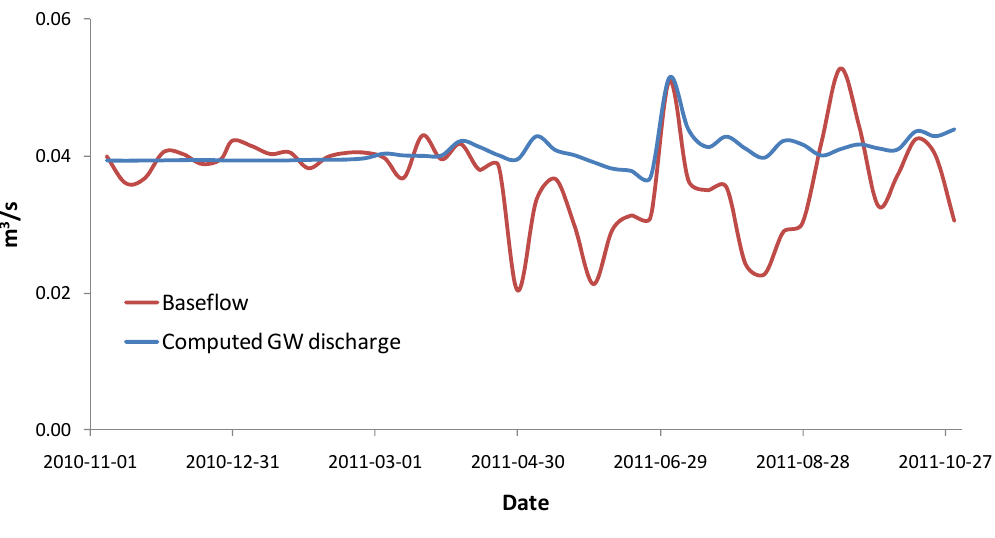
Figure 10. Comparison of simulated groundwater discharge to the Bulang River and the separated base flow from November 2010 to